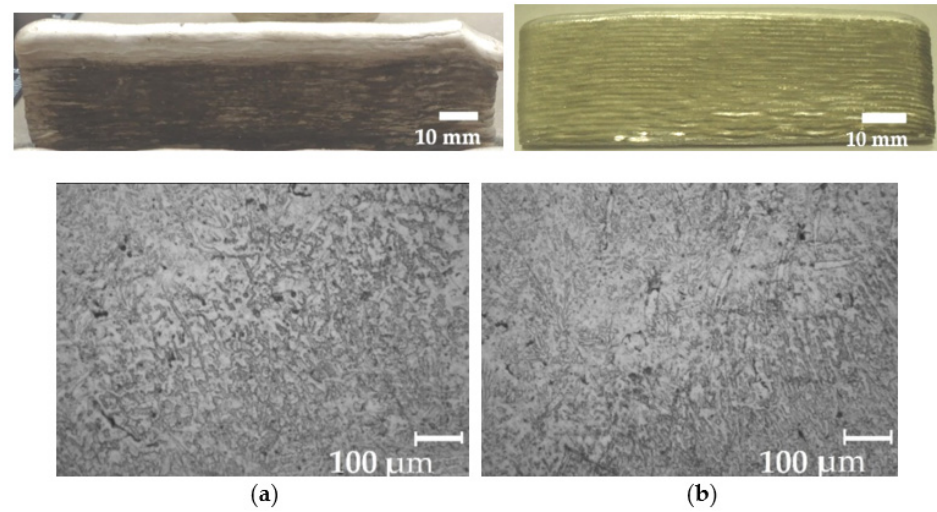
Figure 18. Formation and microstructure of a vertical specimen cross-section with AlMg5Mn1Ti wire of 1.6 mm: ( a ) pure argon, specimen thickness is 6.5 mm, layer thickness is 2–2.5 mm; ( b ) gas mixture with the addition of 1.6 wt.% SF 6 into argon, specimen thickness is 4 mm, layer thickness is 0.8–1 mm.